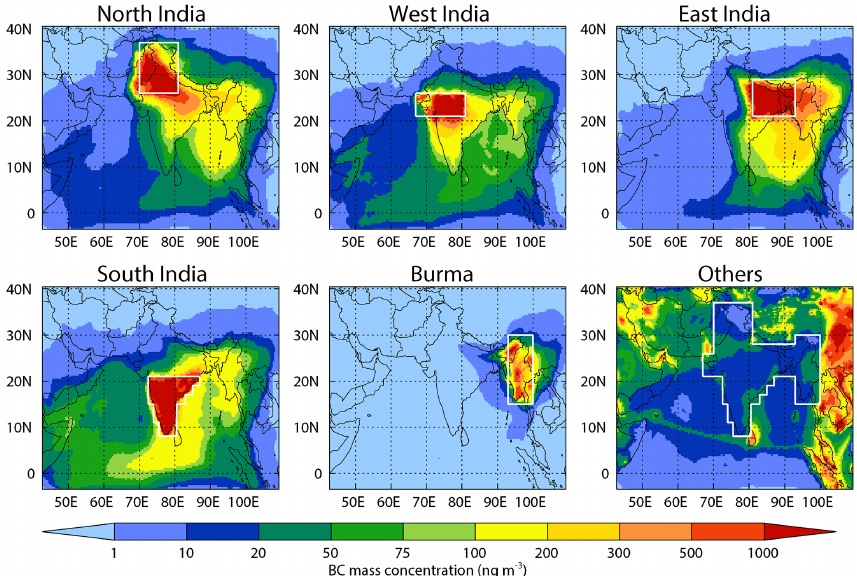
Figure 6. Spatial distributions of anthropogenic BC emitted from north, west, east and south India, Burma and other regions during the ICARB period. White solid lines mark the geographical boundaries of different